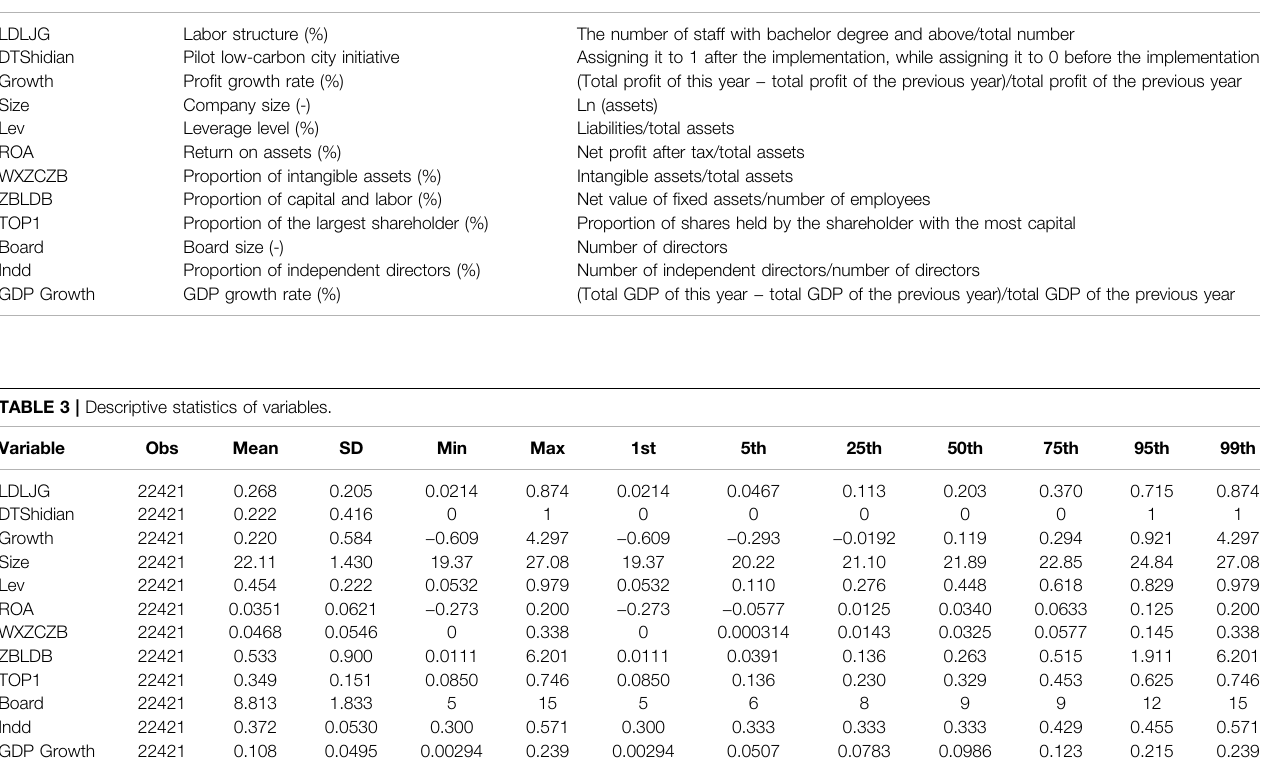
TABLE 2 | Variable de fi nition. Variable